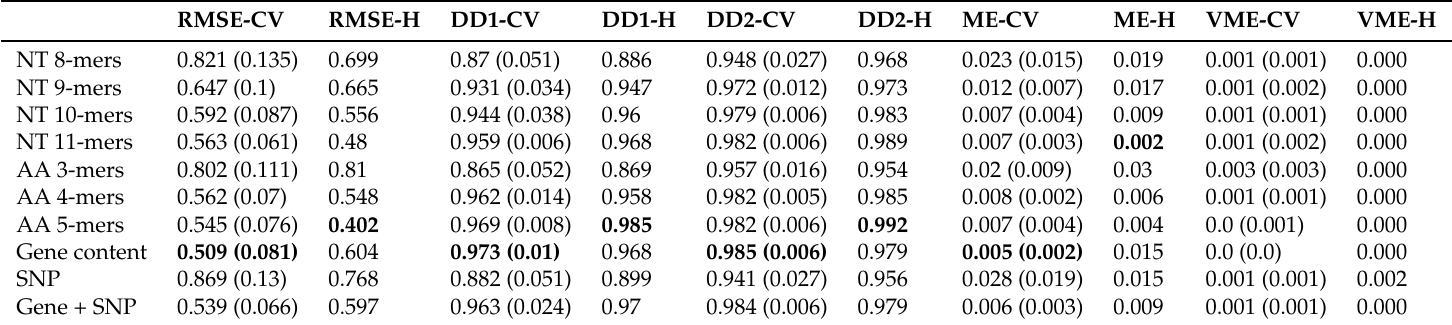
Table A63. S. enterica –tetracycline.